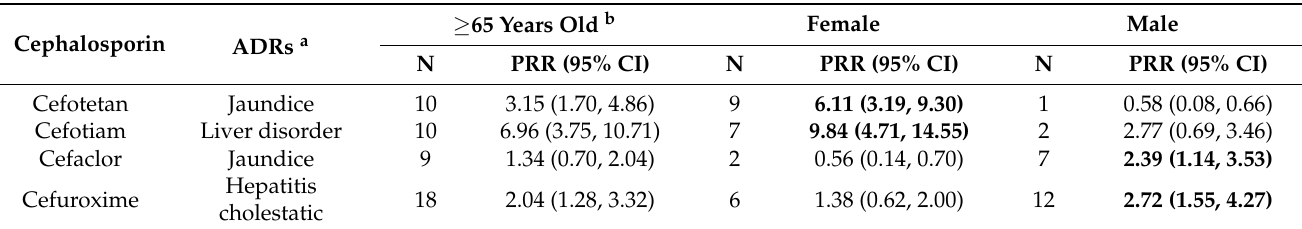
Table 4. Disproportionality for hepatobiliary adverse drug reactions associated with the use of cephalosporin by gender in the